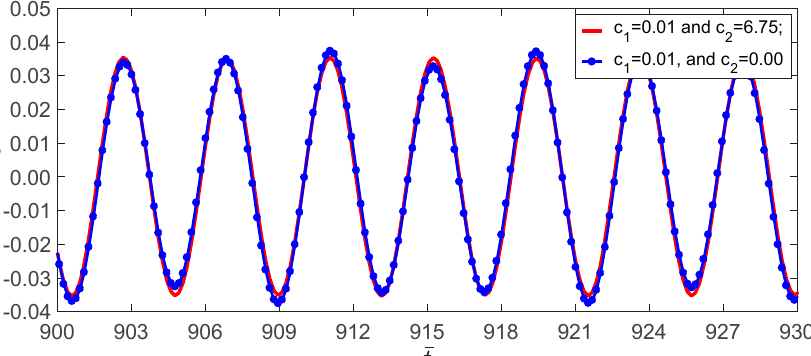
Figure 2. Time evolution of the microbeam’s midpoint displacement of the non-resonance for Ω = 1.5, f = 1 1